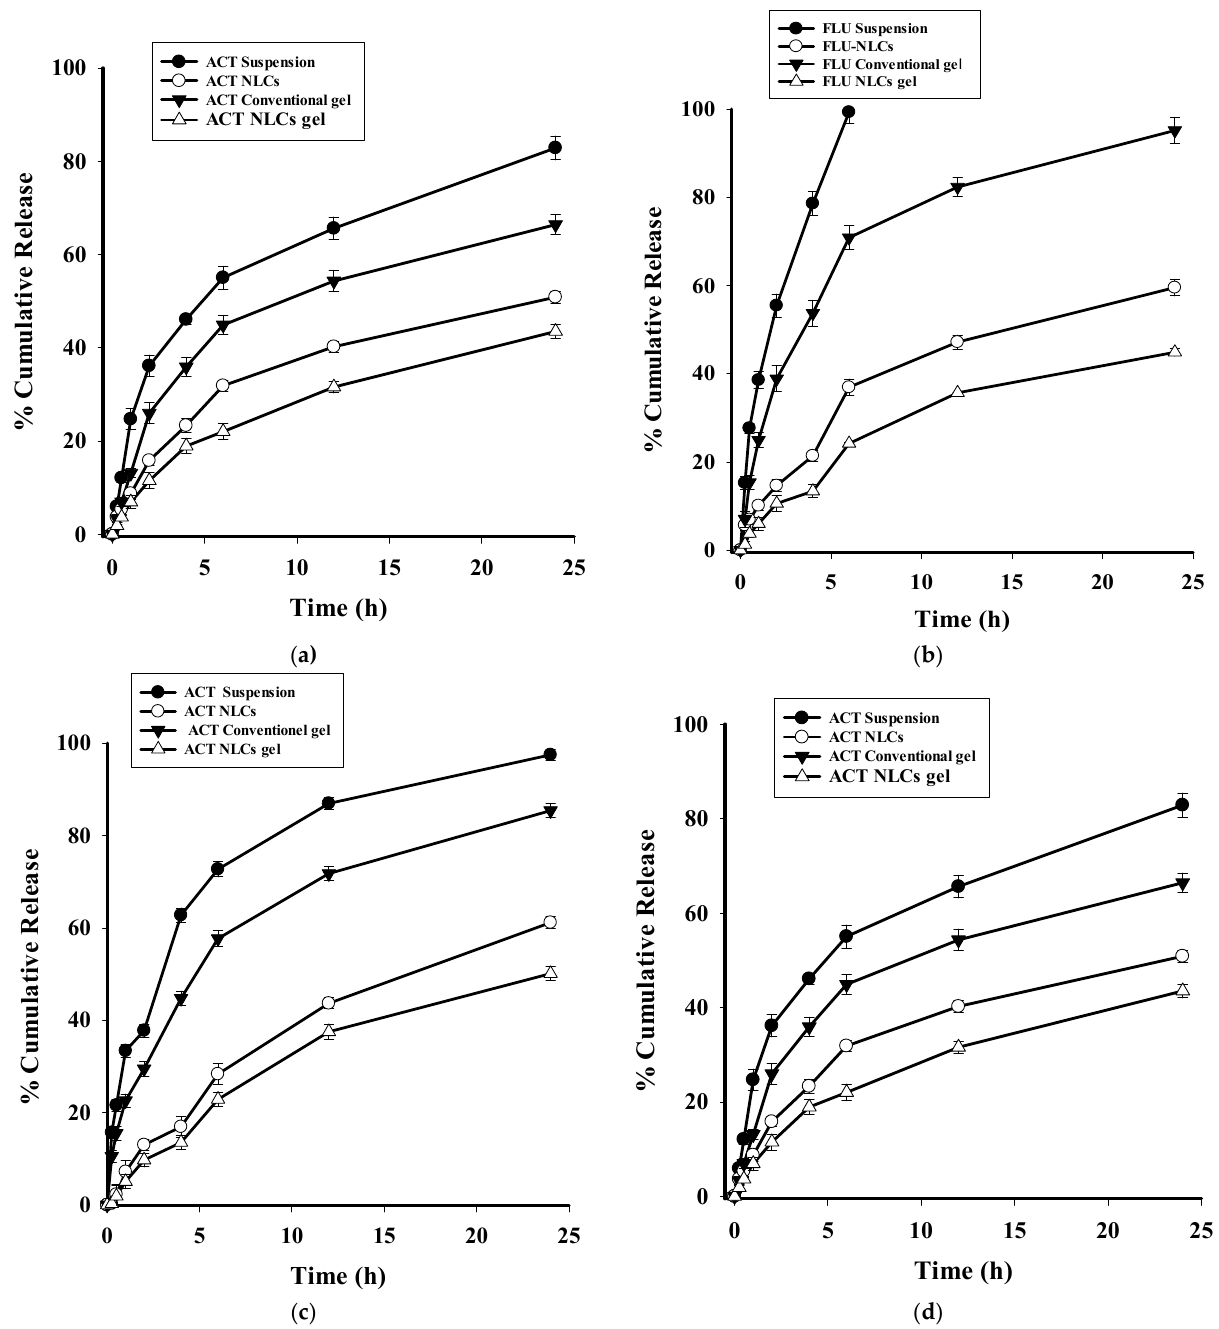
Figure 8. In vitro release profiles of fluocinolone at ( a ) pH of 5.5 and ( b ) pH of 7.4, and acitretin at ( c ) pH of 5.5 and ( d ) pH of 7.4. Table 3. Drug release kinetic models of optimized FLU–ACT-coloaded NLCs.